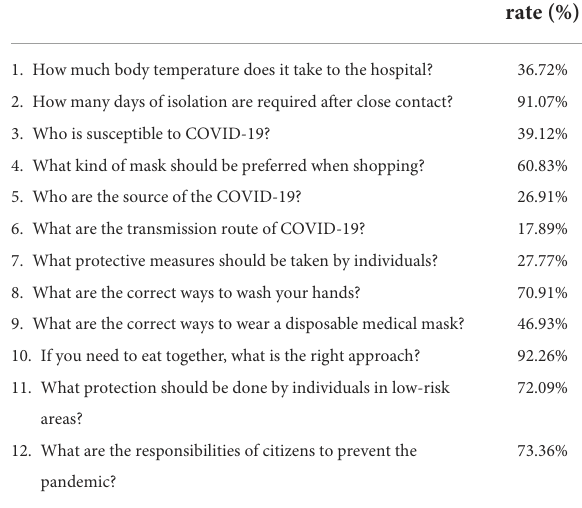
TABLE 1 Questions about COVID-19